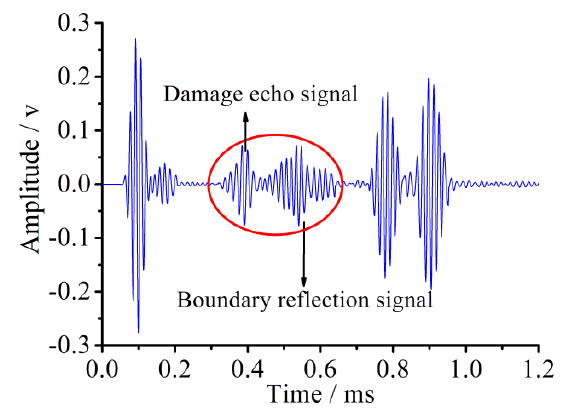
Figure 14. Received voltage signal in the simulation for the pipe with 45° circumferential damage.